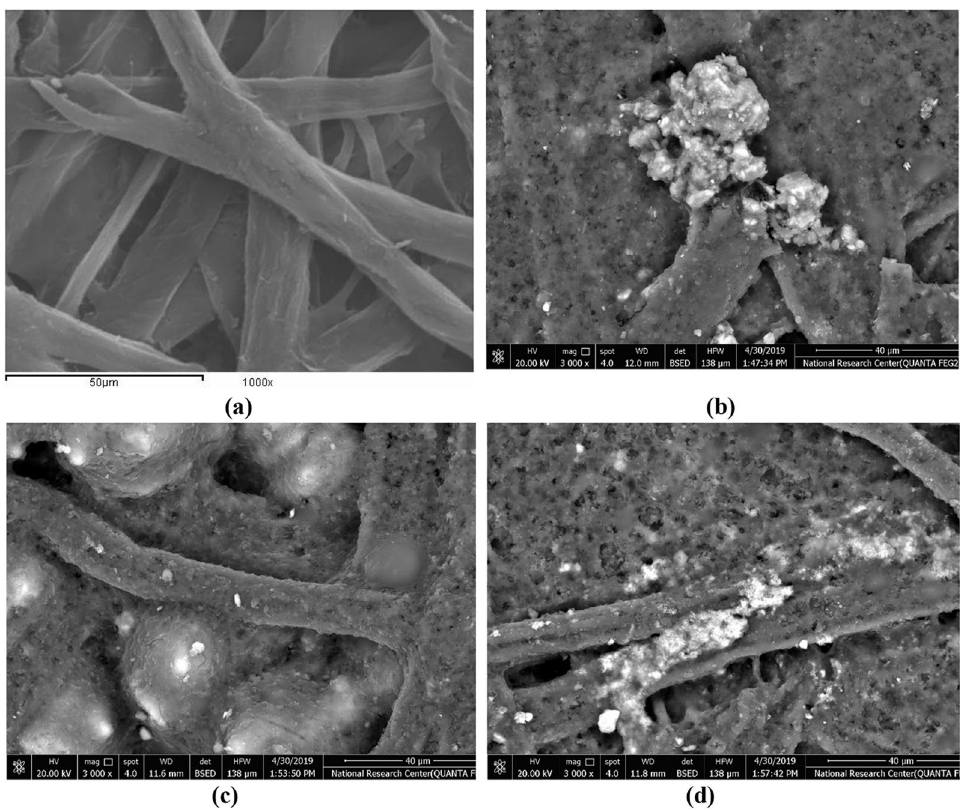
Figure 5. SEM images for paper sheets, ( a ) S0 (blank bagasse), ( b ) S9 (20% CaCO 3 + 0.1% CPAM + 1% Bt), ( c ) S11 (20% RHSA + 0.1% CPAM + 1% Bt) and ( d ) S12 (20% TiO 2 /RHSA + 0.1% CPMA + 1%